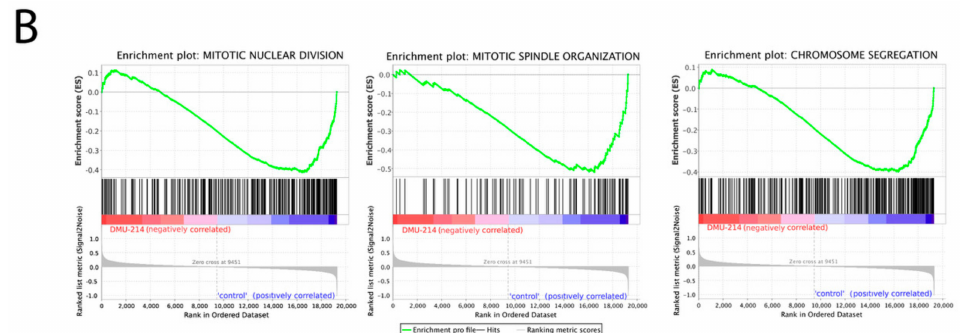
Figure 7. Gene set enrichment analysis. ( A ) Enrichment map of gene sets that were inhibited by DMU-214, from the Reactome database. The thickness of the connecting line corresponds to the level of gene matching to individual terms. ( B ) Enrichment plot of “Mitotic nuclear division”, “Mitotic spindle organization”, “Chromosome segregation”. Each of the graphs shows the value of the enrichment score (ES) indicating the depletion of genes forming these processes under the influence of DMU-214.